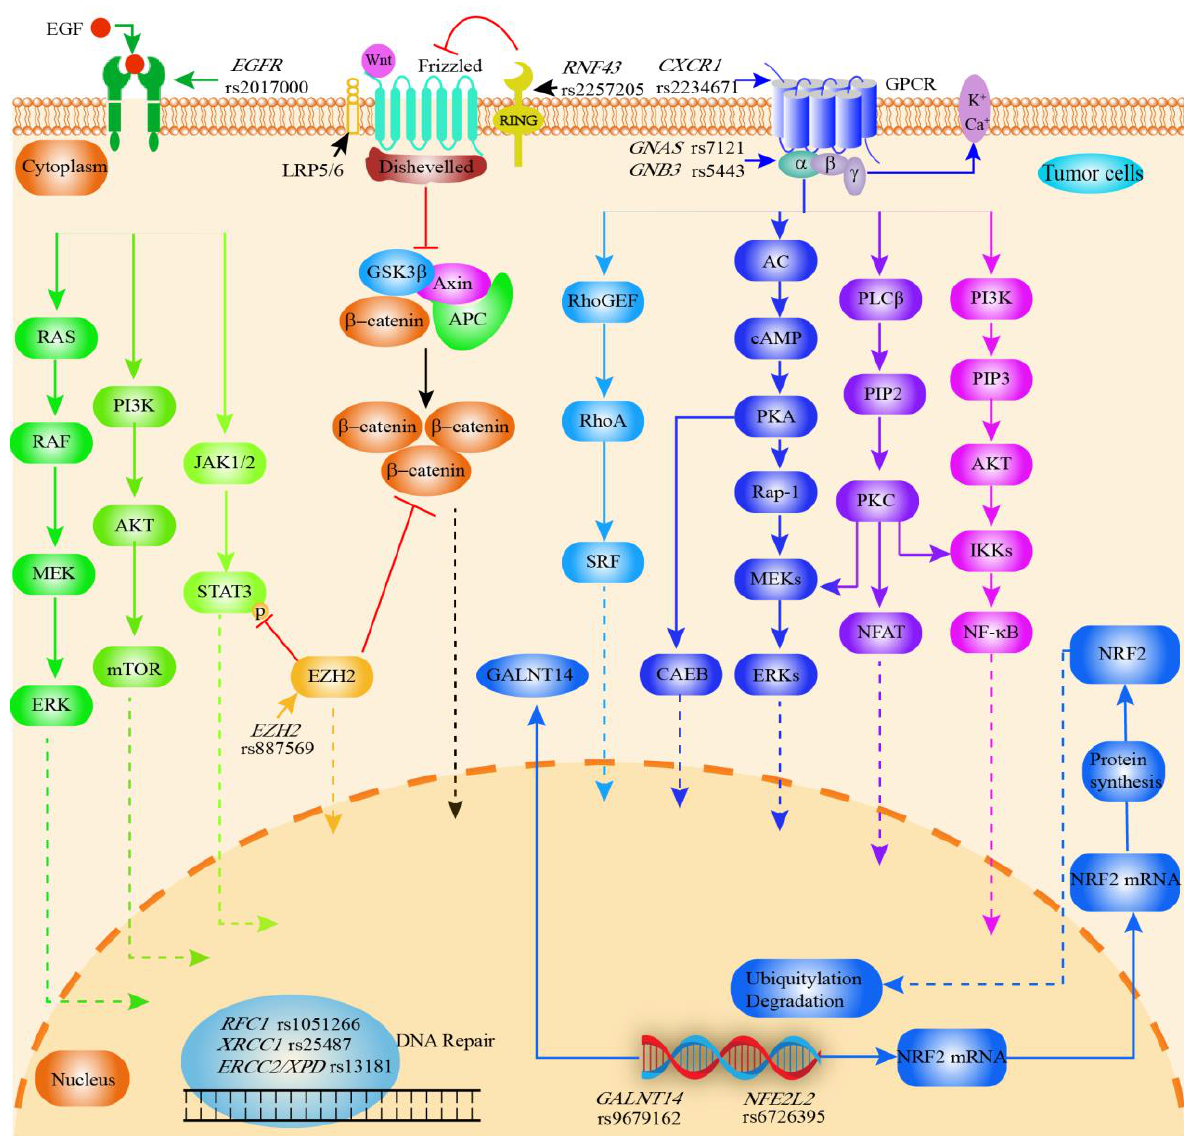
Figure 5. Graphical synopsis of the role of SNPs in prognosis of cholangiocarcinoma. Various SNPs are associated with clinical prognosis of CCA. EGFR rs2017000 affects EGFR expression and thus the EGFR signaling pathway (tumor cell proliferation, angiogenesis, tumor invasion, metastasis and inhibition of apoptosis) . RNF43 rs2257205 inhibits the Wnt signaling pathway, while EZH2 rs887569 inhibits the Wnt signaling and EGFR/JAK/STAT signaling pathway. G proteins are activated upon binding to ligands, initiating different signaling pathways and leading to various biological effects. CXCR1 rs2234671 (encodes the IL8 receptor) , GNAS rs7121 (encodes an activated G protein alpha subunit) and GNB3 rs5443 (encodes the β 3 subunit of the G protein) are associated with G protein-coupled receptor-mediated signaling pathways. As an important transcription factor, NRF2 (encoded by NFE2L2 ) regulates antioxidant, cytoprotective, and metabolic enzymes and is involved associated with cancer prognosis ( RFC1 rs1051266; XRCC1 rs25487; ERCC2 rs13181). RFC1 is also associated with the replication of DNA. GALNT14 enzymes are associated with the O-glycosylation of proteins. GALNT14 rs9617162 affects the activity of GALNT14. AC, adenylate cyclase; AKT,